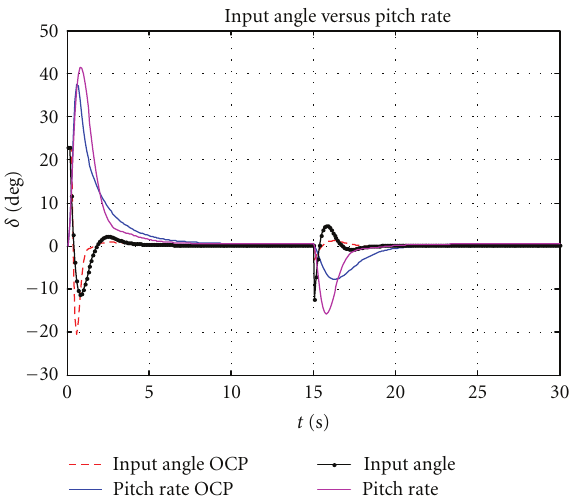
Figure 5: Input angle, pitch rate versus pitch